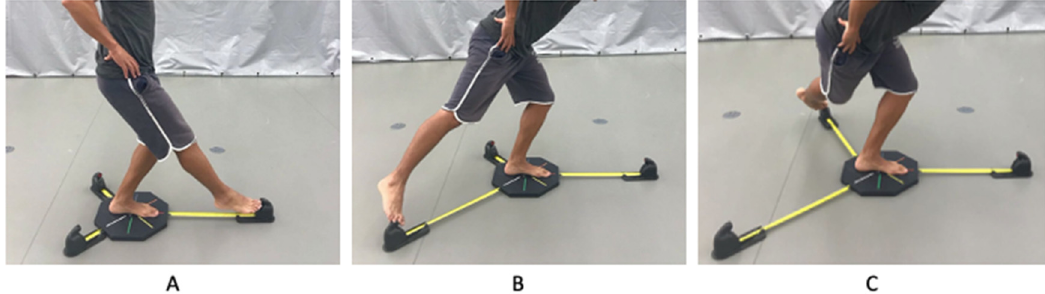
Figure 1. ( A ) Y balance test anterior reach direction; ( B ) Y balance test posteromedial reach direction; ( C ) Y balance test posterolateral reach direction.